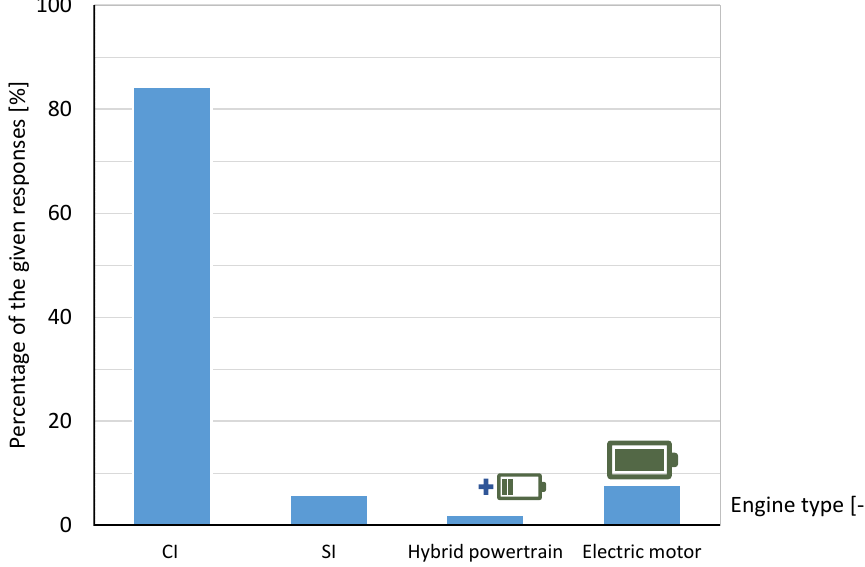
Figure 1. Current status of the surveyed fleets in terms of their propulsion system (based on the survey).